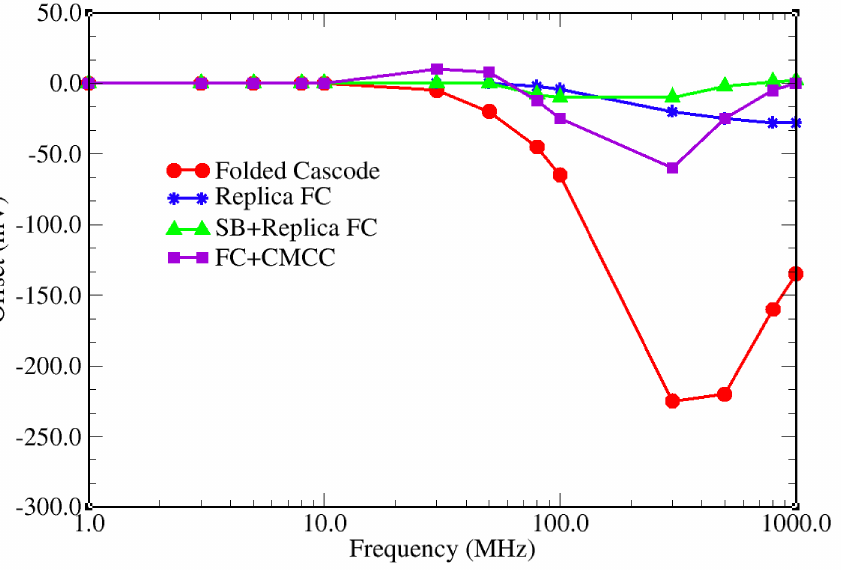
Figure 13. Offset induced by 1.65 Vpp EMI coupled to all of the pins of FC